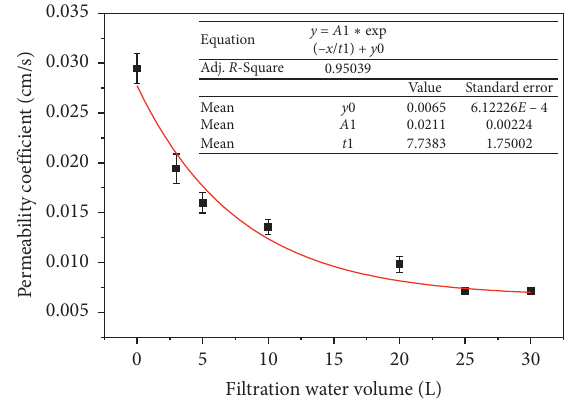
Figure 5: Changes in the permeability coefficient with filtration